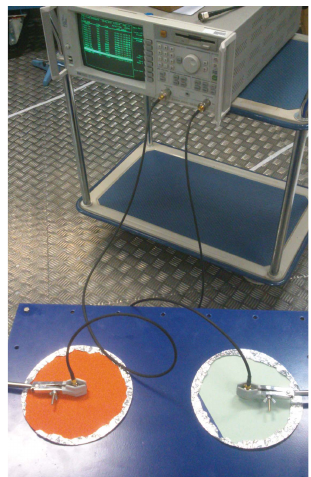
Figure 3. Two 10 cm monopole antennas with ground plane and an Agilent E8364BD network analyser for the measurement of the S 21 parameter of the